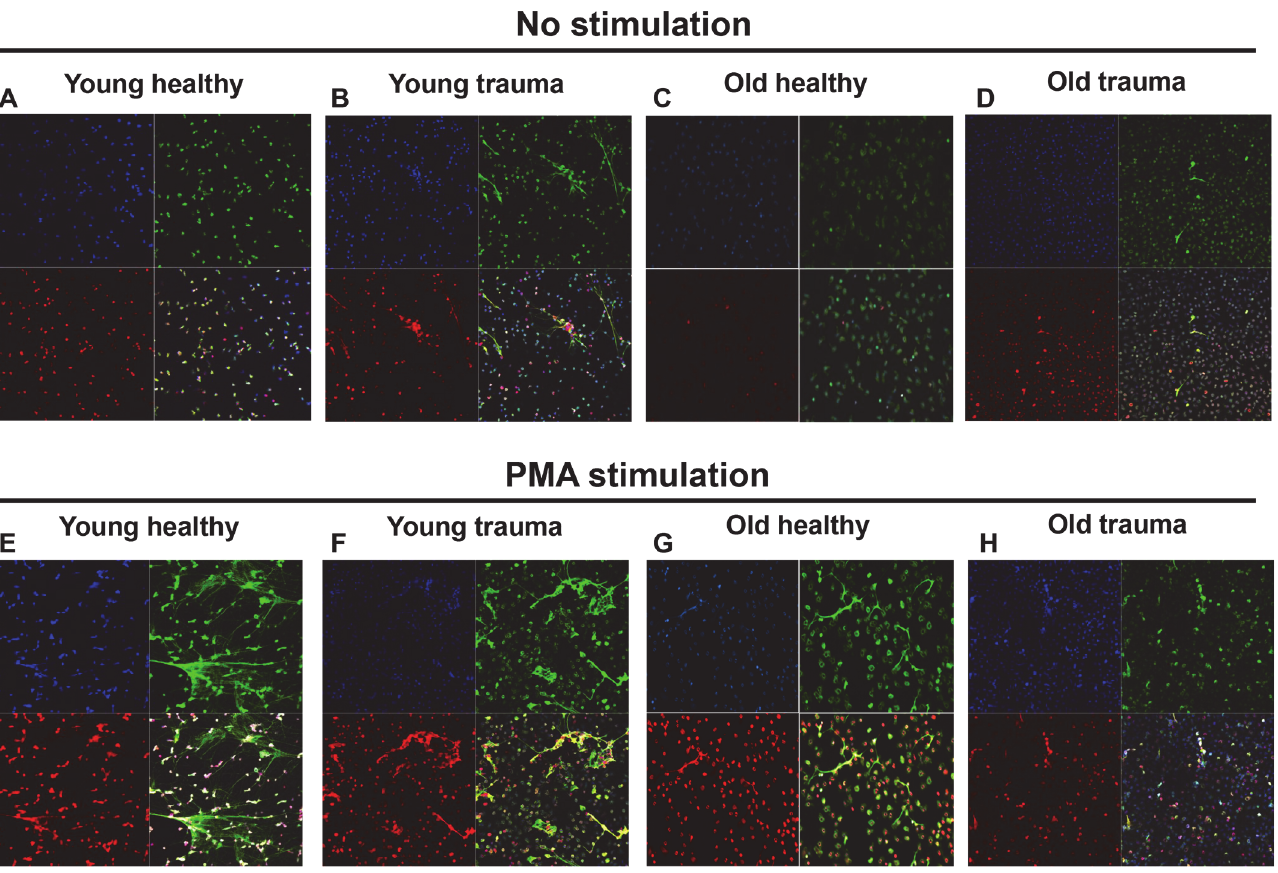
Fig 5. NET formation in young and old trauma patients and volunteers. NET formation in PMN isolated from young healthy volunteers (n = 10, A and E ), young trauma patients (n = 7, B and F ), old healthy volunteers (n = 6, C and G ), and old trauma patients (n = 5, D and H ) was evaluated. A-D : PMN were immediately fixed after attachment. E-H : PMN were stimulated with 20 nM PMA for 3 – 4